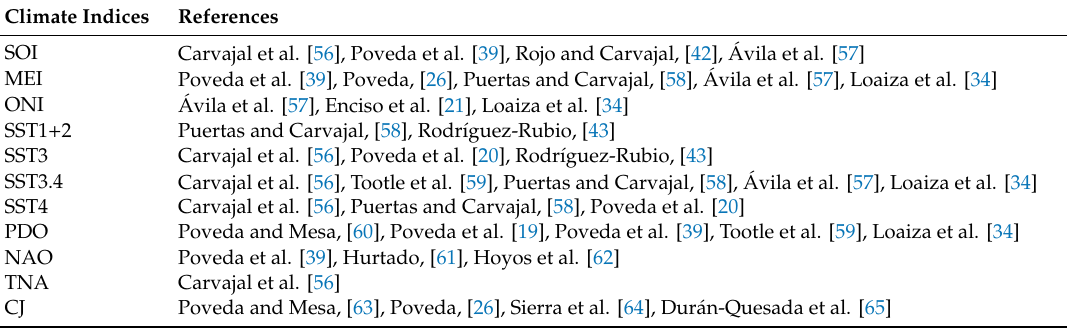
Table 2. Climate indices used in the Colombian Biogeographic Choc ó (CBC) region and publications. Climate